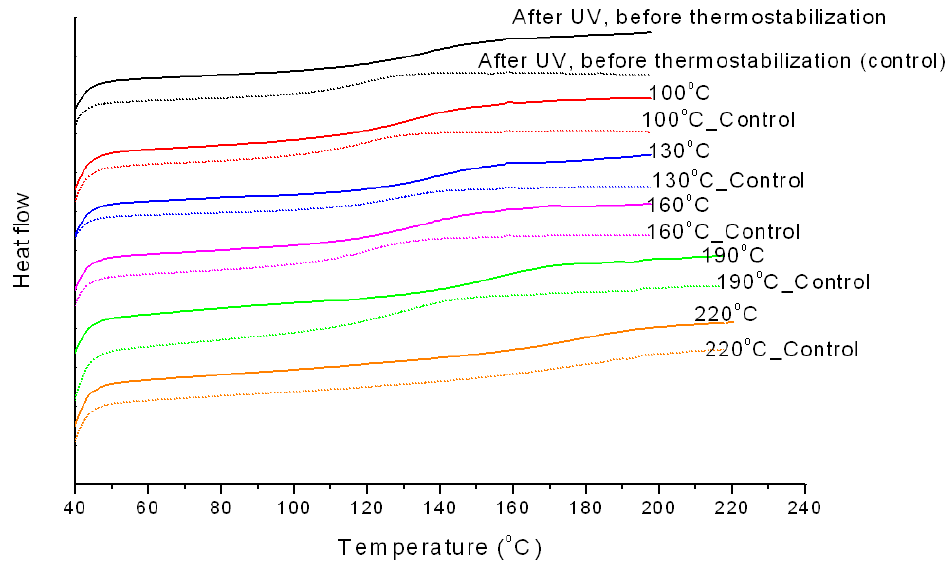
Figure 4. Differential scanning calorimetry (DSC) thermograms of various lignin-based precursor fibers thermally treated up to different temperatures. Solid curves: thermograms of fibers after UV irradiation; dashed curves: thermograms of control fibers without UV